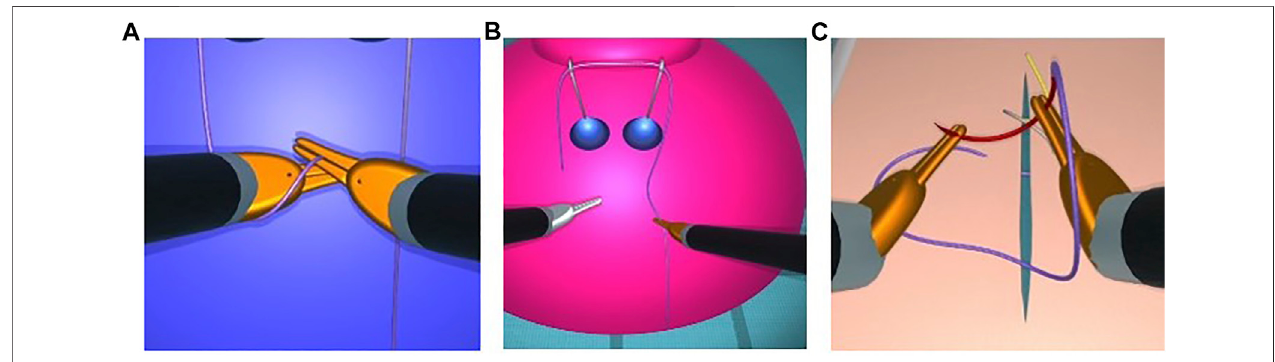
FIGURE14| Visualcuesforexcessiveforcesduringcollisions:Visualcuesforexcessiveforcesduringcollisions.Instrumenttipsturningfromsilvertoorangeduring collision when forming aloop with athread for knot-tying (A) , right instrument tip turning orange during collision with the dome, which turns from blue to pink (B) , double grasping with shearing forces during needle manipulation with both instrument tips turning orange, and the needle approximating the breakage point as represented by its color change to red (C) . Animated scenes are shown in the Supplementary Video S1 .